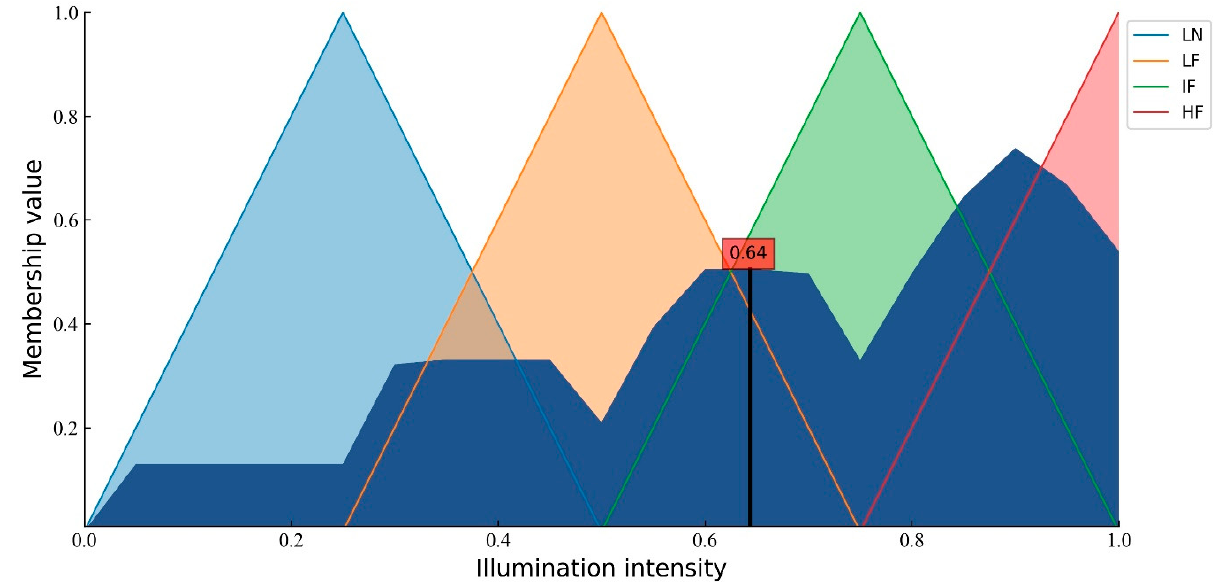
Figure 10. Defuzzification of the aggregated membership functions.